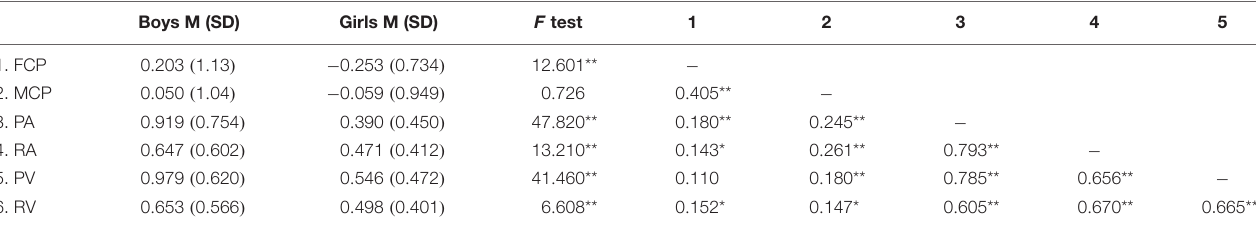
TABLE 1 | Descriptive statistics, ANOVA tests, and Pearson correlations for the study